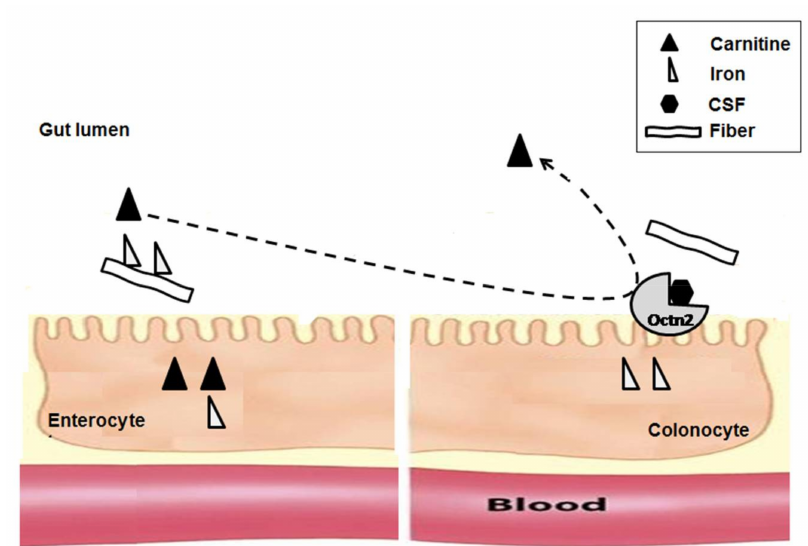
Figure 1. Carnitine and iron absorption in the intestines. Non-absorbed dietary carnitine reaches the large intestine (colonocytes), where bacterial sporulation-stimulating factor (CSF) competes with carnitine on the organic cation transporter novel 2 (Octn2) transporter, leading to reduced carnitine absorption. Iron conjugated to fiber is absorbed less in the small intestine (enterocytes), but is absorbed more in the large intestine, as bacterial fermentation can dissociate such